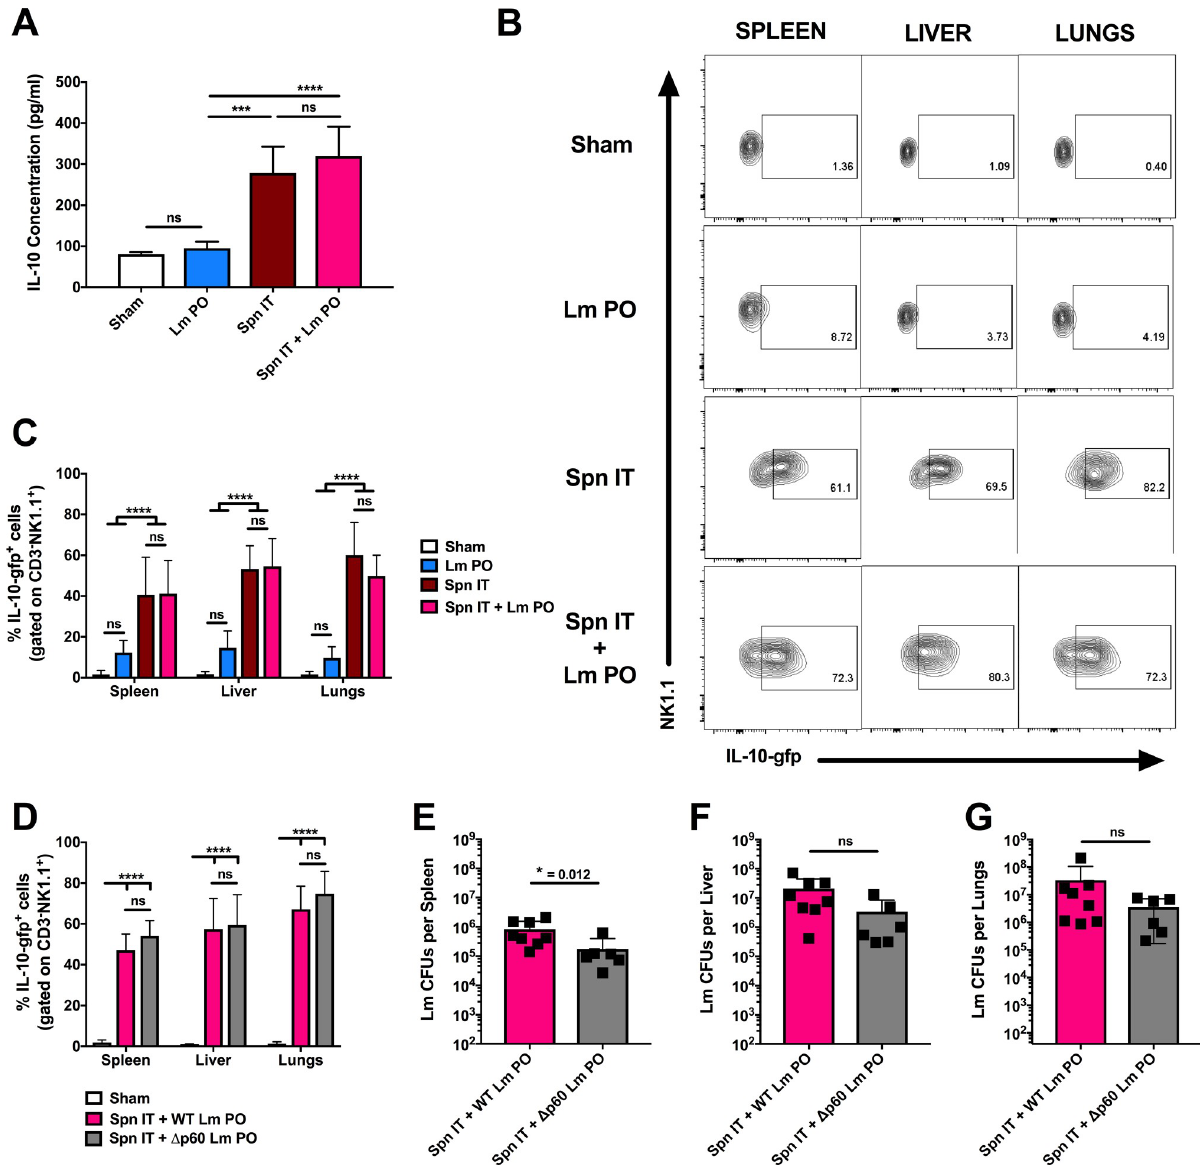
Fig 3. Susceptibility to oral Lm correlates with IL-10 production by NK cells . B6. tiger ( Il10 -gfp reporter) male and female age-matched mice were infected with sham control, Lm PO, Spn IT, or Spn IT + Lm PO and harvested at 3 dpi. (A) Upon sacrifice, blood was collected by cardiac puncture, and serum IL-10 was measured by ELISA. Data represent mean ± SD, One-way ANOVA, pooled from 2 experiments, 4–6 mice per group, ��� p < 0.0002, ���� p < 0.0001 between indicated groups. (B) Representative flow plots of reporter staining in CD3 - NK1.1 + NK cells in indicated tissues. (C) Quantitation of percent CD3 - NK1.1 + NK cells that stained positive for IL-10-gfp + in spleens, livers, and lungs. Data represent mean ± SD, Two-way ANOVA, pooled from 3 experiments, 6–12 mice per group, ���� p < 0.0001 between indicated groups. B6. tiger ( Il10 -gfp reporter) male and female age- matched mice were infected with sham control, Spn IT + WT Lm PO, or Spn IT + Δ p60 Lm Lm PO and harvested at 3 dpi for flow analysis and CFU enumeration. (D) Quantitation of percent CD3 - NK1.1 + NK cells that stained positive for IL-10-gfp + in spleens, livers, and lungs. Data represent mean ± SD, Two-way ANOVA, pooled from 2 experiments, 6–8 mice per group, ���� p < 0.0001 between indicated groups. Lm burdens were enumerated from (E) spleens, (F) livers, (G) lungs. Data represent mean ± SD, Mann-Whitney t-test, pooled from 2 experiments, 6–8 mice per group, � p <